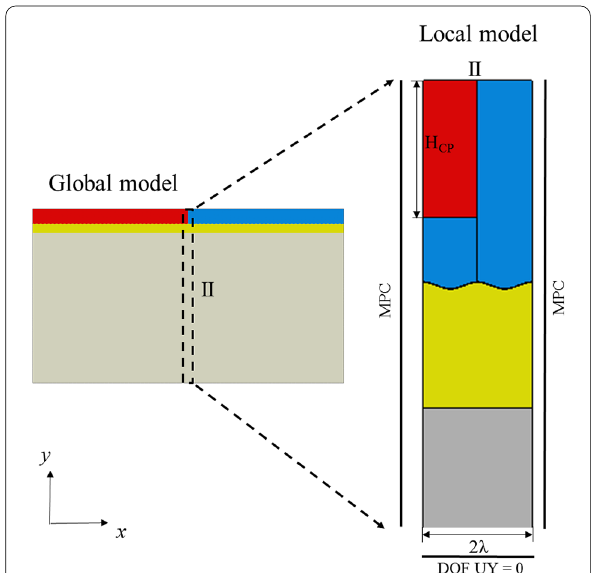
Figure 3 Local model of critical Zone